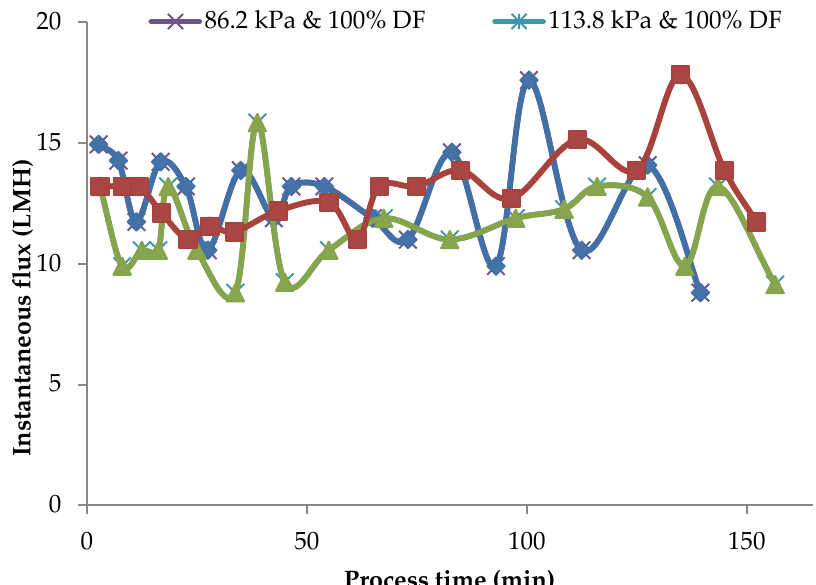
Figure 7. Instantaneous flux obtained for 86.2 kPa TMP at 100 and 150% DF and for 113.8 kPa and 100% DF. The data are from the pilot plant run.